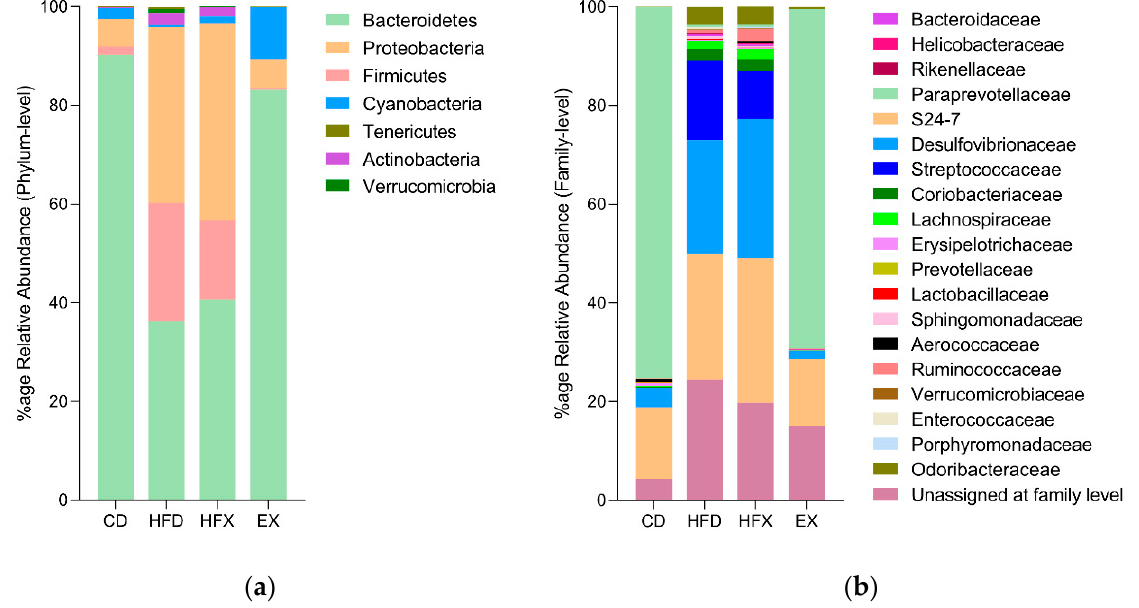
Figure 4. Taxonomic composition of mice gut microbiota at ( a ) phylum level and ( b ) family level. Two-way ANOVA and multiple comparison tests were used to determine significance ( p < 0.05).